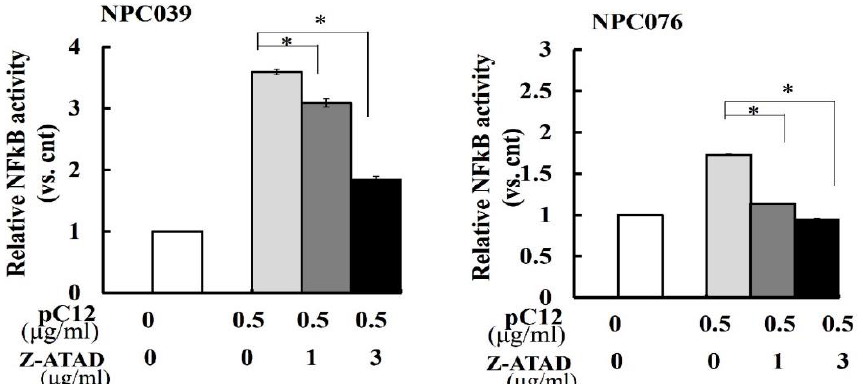
Figure 5. The hCasp12-mediated NF- κB activity inhibited by Casp12 inhibitor. NPC cells were transfected with pC12 plasmid, NF- κB reporter /pSV- β -galactosidase plasmids in the presence of hCasp12 inhibitor (z-ATAD-fmk) for 24 h. The cell lysates were used to detect the luciferase activity. Results are presented as the ratio of luciferase to β -gal activities normalized to untreated cells. The data from three independent experiments are graphed as the mean ± s.e.m., * p < 0.05.